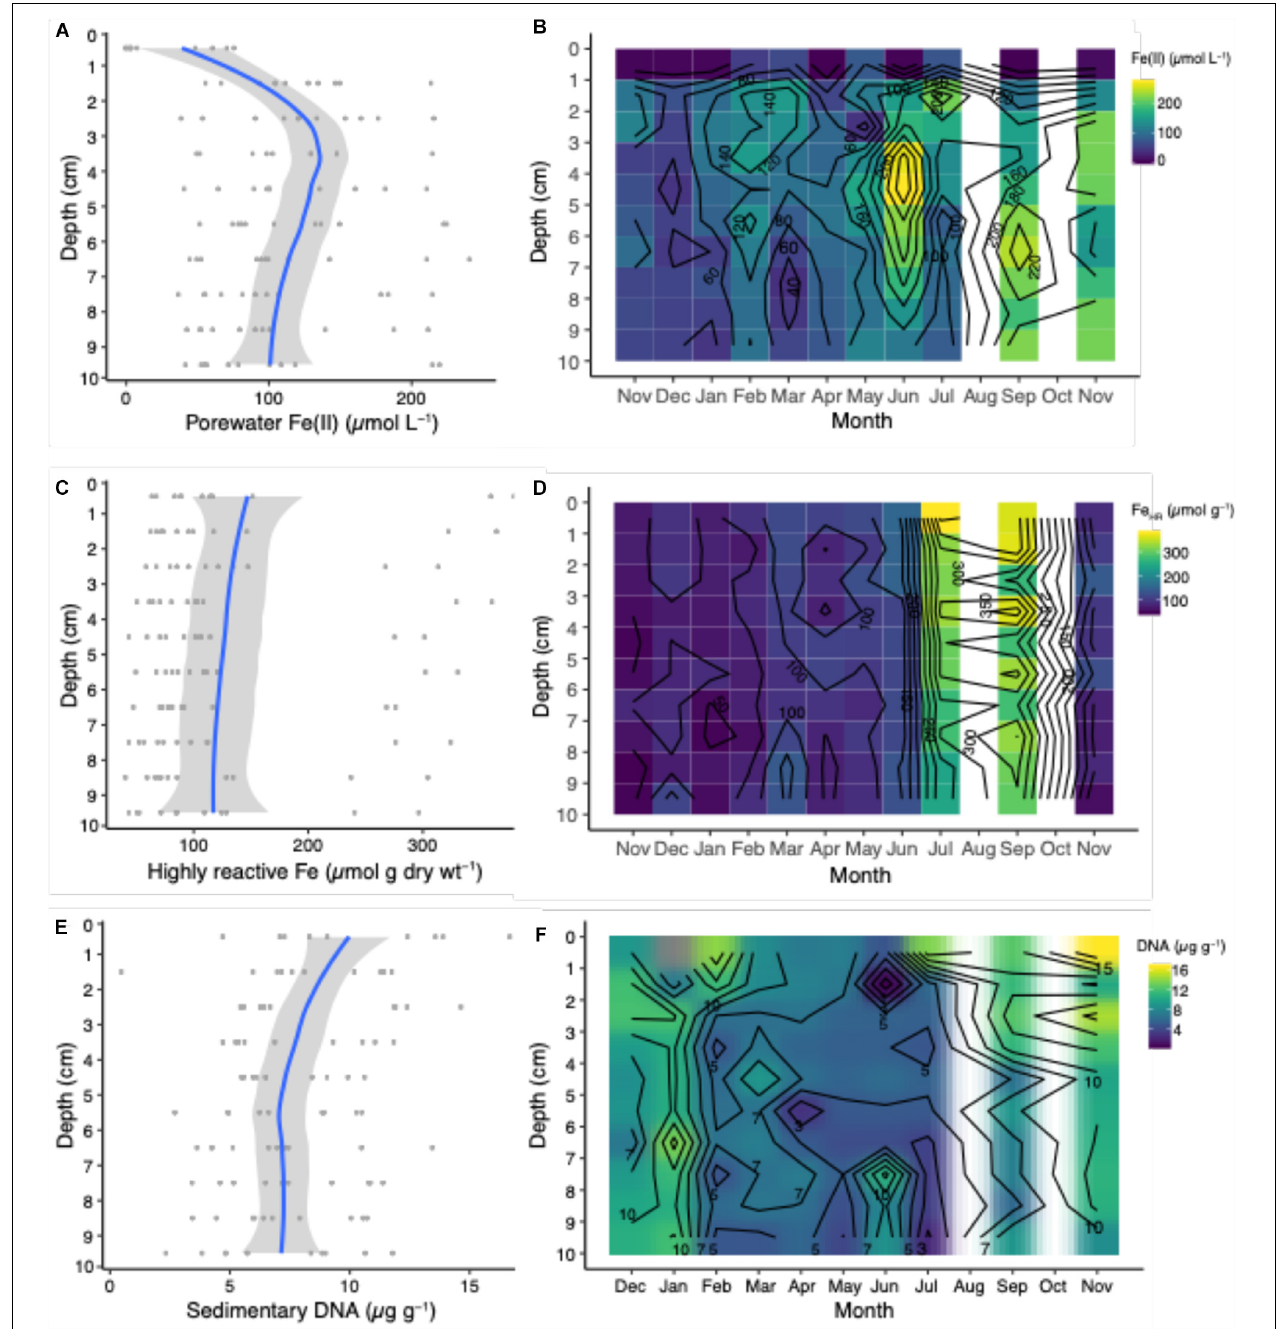
FIGURE 2 | Porewater Fe(II), highly reactive Fe concentrations, and sedimentary DNA profiles from averages across depths and season (A,C,E) and over the annual seasonal cycle from Nov. 2015 to Nov. 2016 (B,D,F) . Blue lines represent mean concentrations calculated from the individual seasonal data points (dark gray circles) and light gray shaded area is the 95% confidence